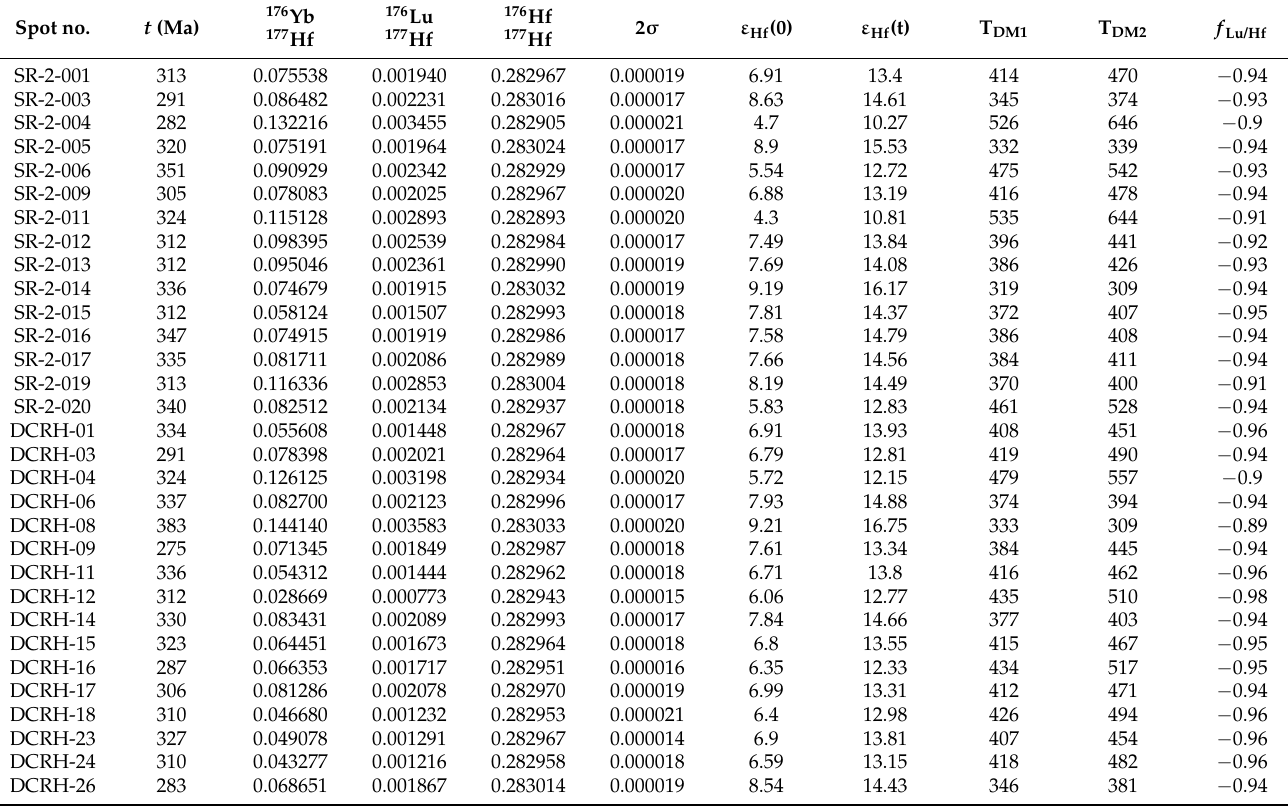
Table 3. Hf isotopic data of zircons from the SR2 and SR1 in the Sayashk Sn deposit. Spot